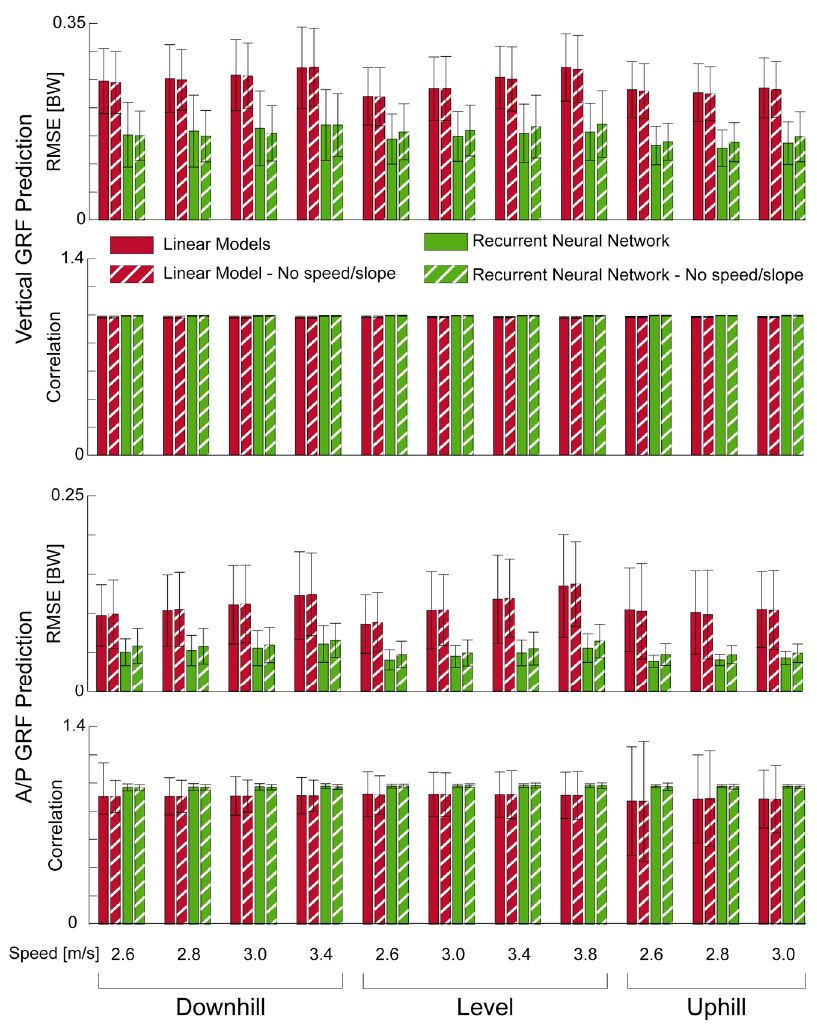
Figure 4. Average (N = 18) summary metrics for vertical and anterior/posterior (A/P) ground reaction force (GRF) prediction. Downhill and uphill running was performed at 6° (10.5% grade). Error bars represent standard deviations.